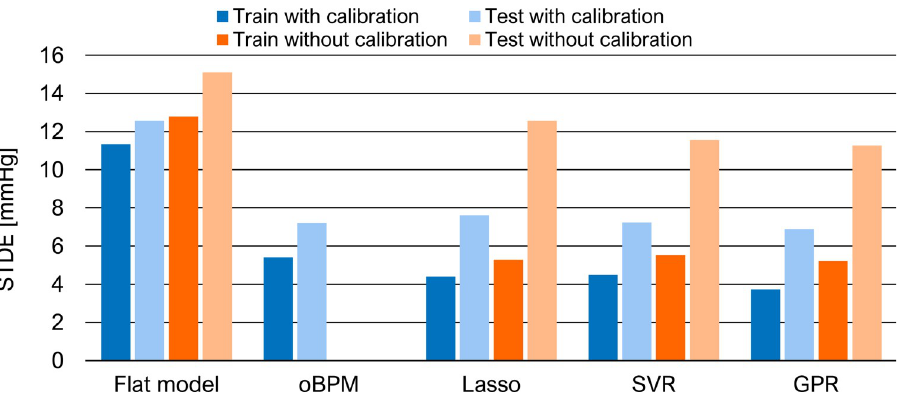
Fig 6. Performance of different ML models in term of STDE in mmHg for DBP estimation with and without